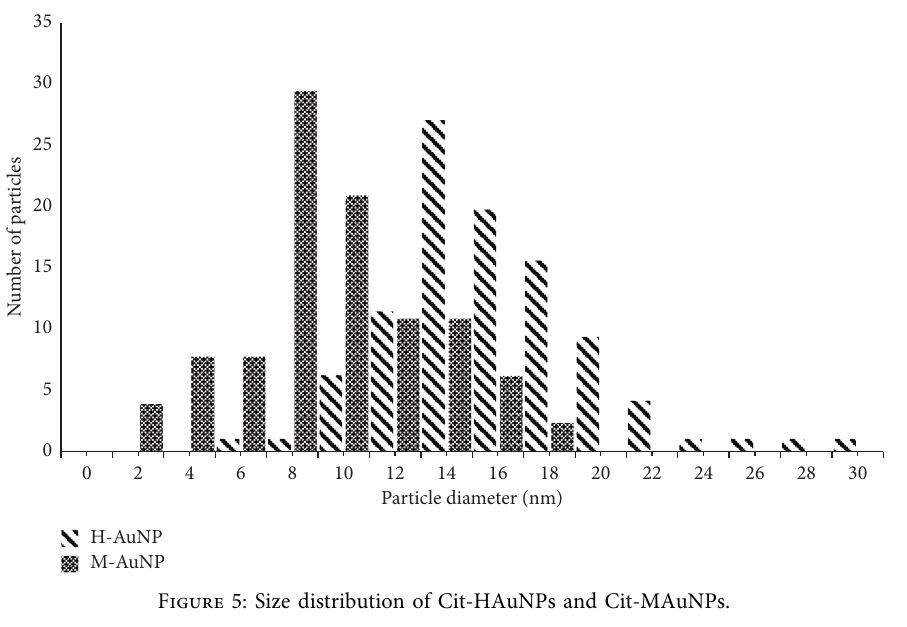
Figure 5: Size distribution of Cit-HAuNPs and Cit-MAuNPs.